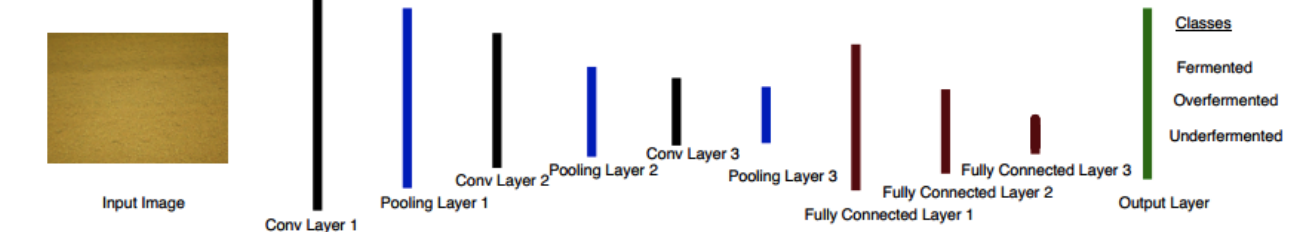
Figure 4. The TeaNet architecture proposed in Kimutai et al. (2020) for optimum detection of tea fermentation.